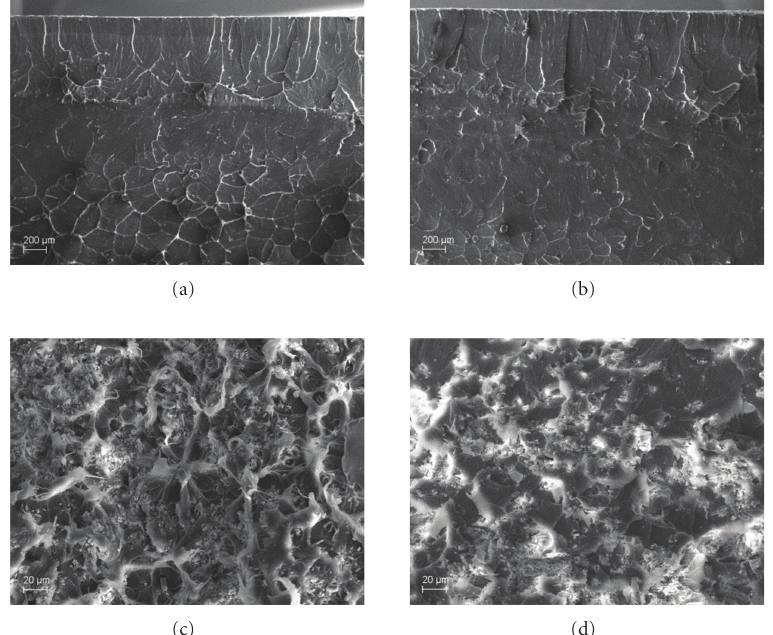
Figure 7: Permolecular structure of the implanted UHMWPE (a), nanocomposite UHMWPE +0.5 wt.% HA (b) and microcomposites: UHMWPE +10wt.% HA (c), UHMWPE +20 wt.% HA (d). Dose: N + 1 · 10 17